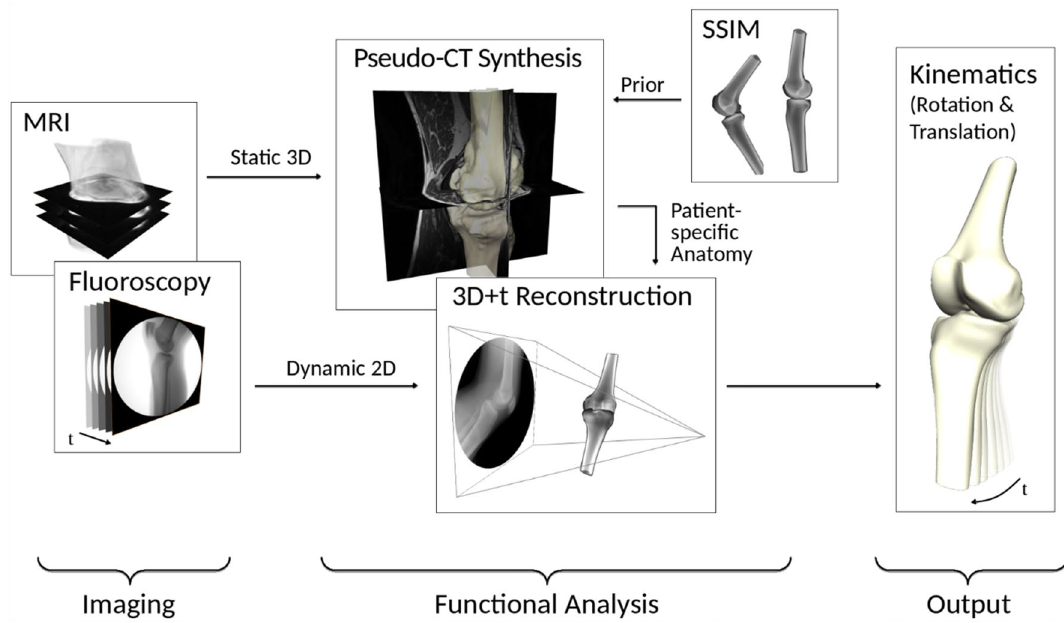
Figure 2. Determination of kinematic in vivo data from MRI and fluoroscopy